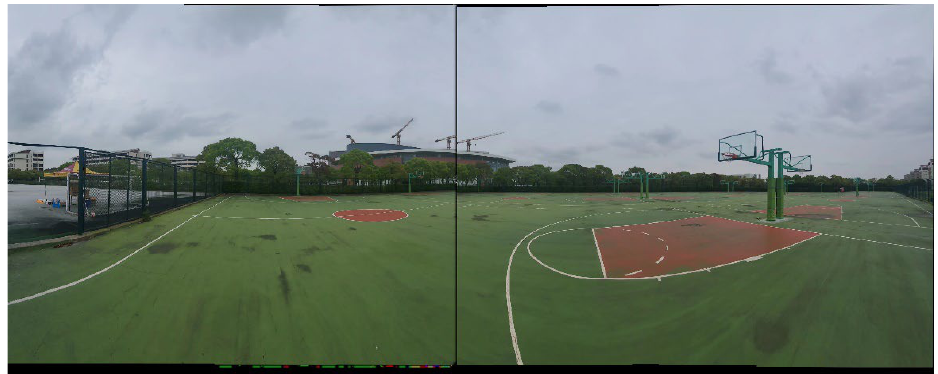
Figure 6. The results obtained based on the binary tree model.